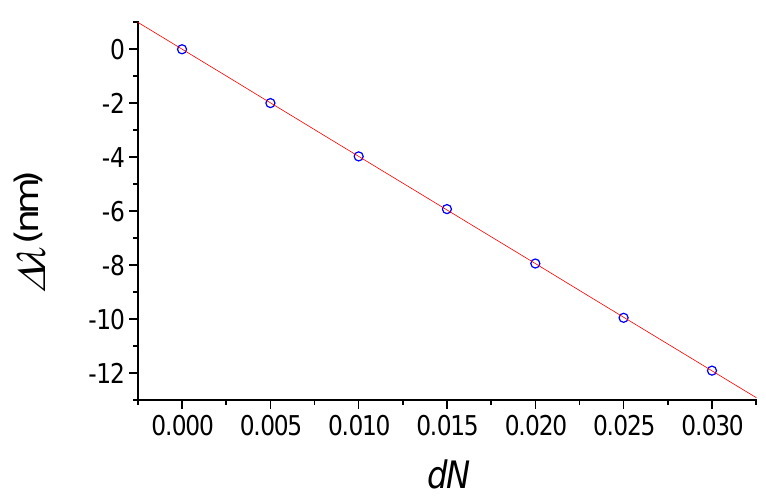
Figure 8. Dependence of drop wavelength shift as a function of index change dN in the water. W = H =1.0 µm. The simulation by 2D FDTD.